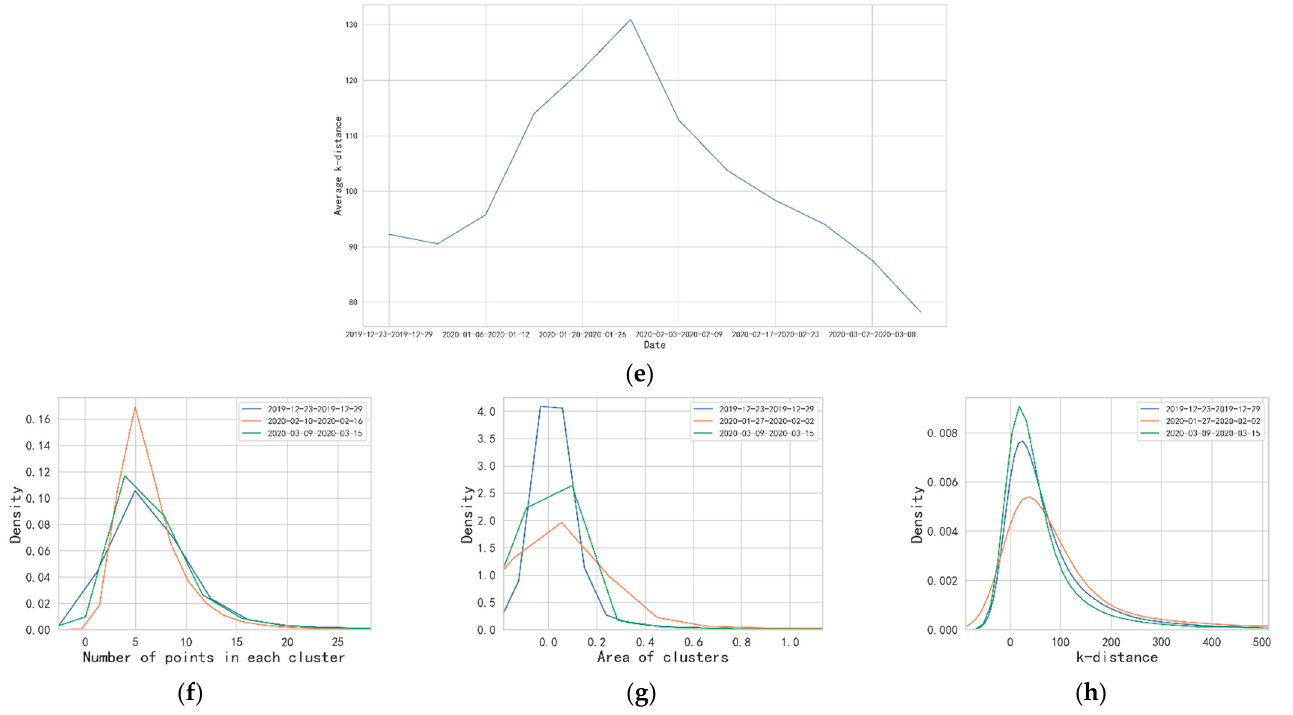
Figure 16. Weekly variation of different features: ( a ) average number of points in each cluster, ( b ) average area of clusters, ( c ) sum average area of clusters, ( d ) area occupied by each point, and ( e ) average k-distance. Additionally, the distribution of ( f ) number of points, ( g ) area, and ( h ) k-distance in specific weeks were shown.